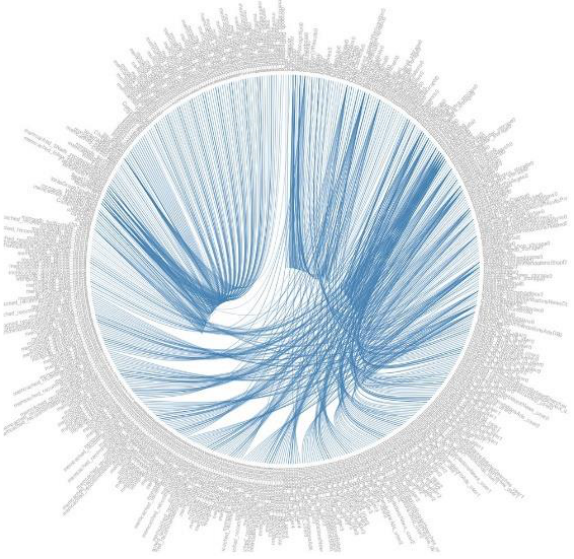
Figure 4. A death star graph showing inter-relationships among microservices [34].